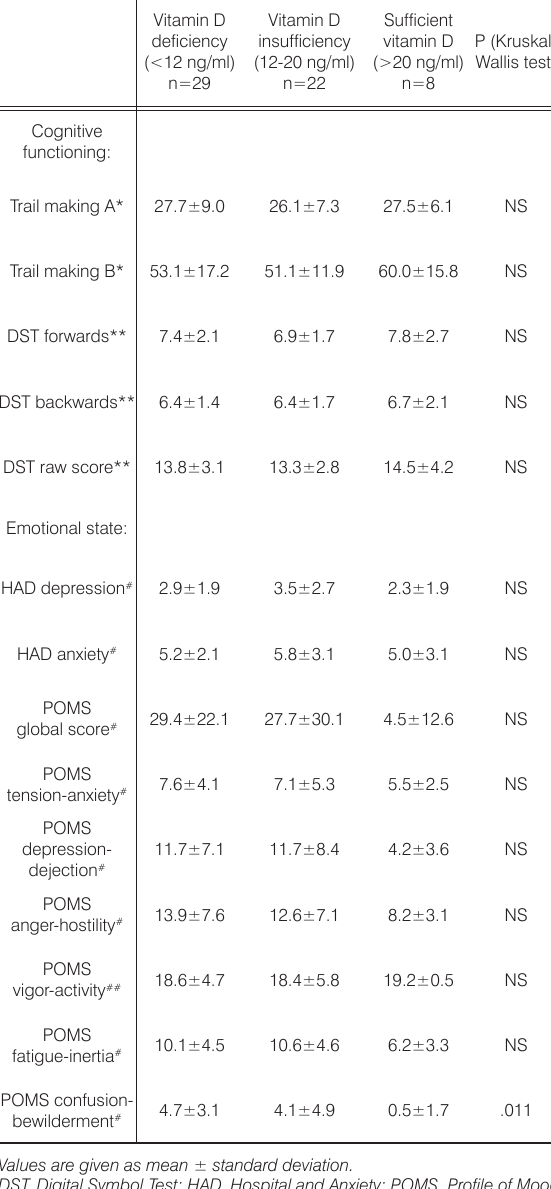
Table 6 Cognitive functioning and emotional state in different subgroups of medical students by vitamin D concentration Vitamin D